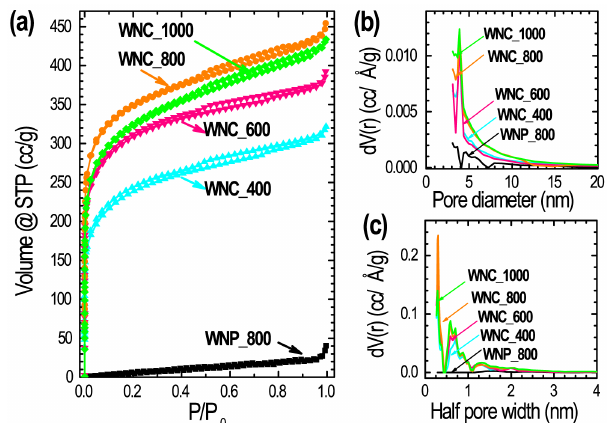
Figure 2. ( a ) Nitrogen sorption (adsorption / desorption) isotherms of WNP_800, WNC_400, WNC_600, WNC_800, and WNC_1000 measured at 77 K, and the pore size distributions profiles obtained by